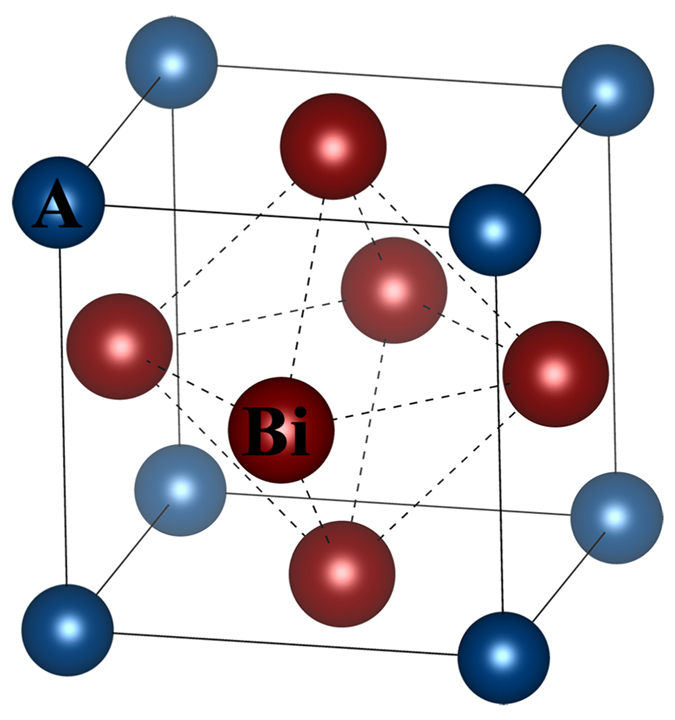
Crystal structure of ABi3.Bi-rich superconductors ABi3 (A = Sr and Ba) have a simple AuCu3 structure, in which A atoms locate at the corners of the unit cell, while Bi atoms locate at the face centers.